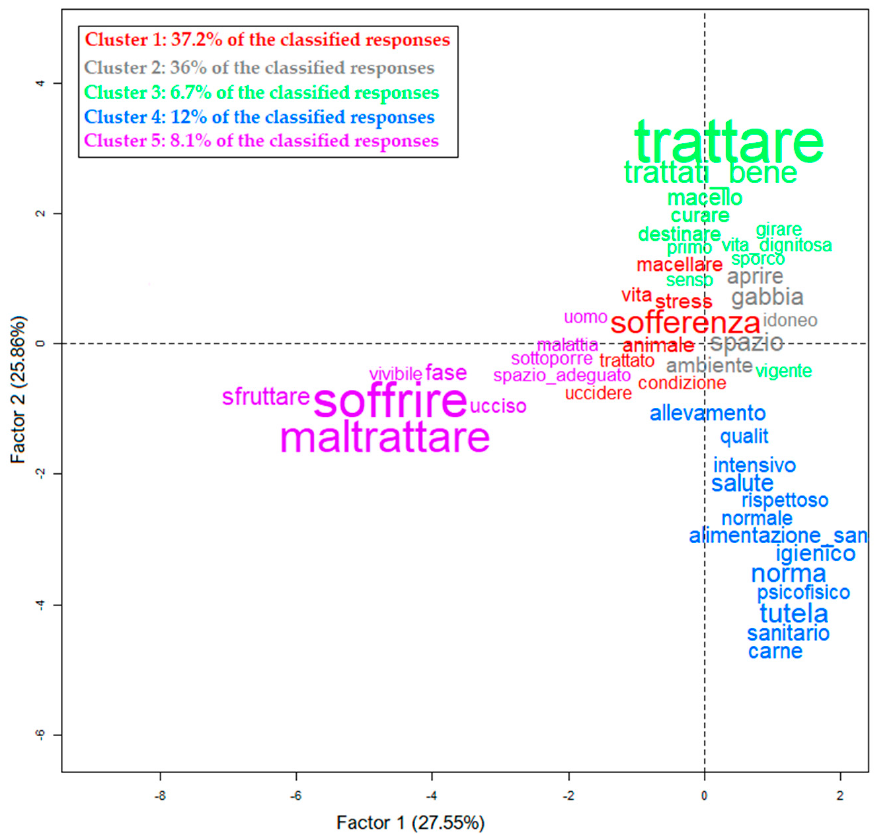
Figure 6. For you, what is the meaning of the expression animal welfare? Write your definition below ( n = 792). Projection of the five clusters identified (Reinert method) on the Cartesian plane. Each color represents a cluster. The size of the words is proportional to the association score (chi-square index) with the corresponding cluster. The translation of words is available in Appendix B, Figure A2.